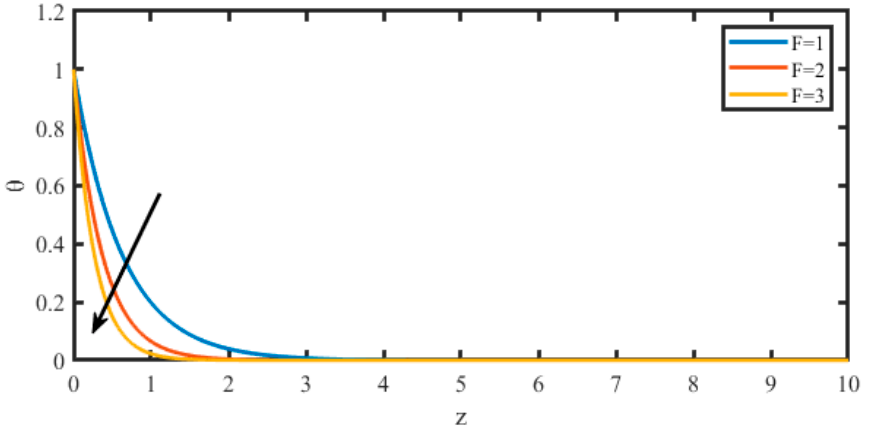
Figure 10. The influence of the radiation parameter F on the temperature profiles.